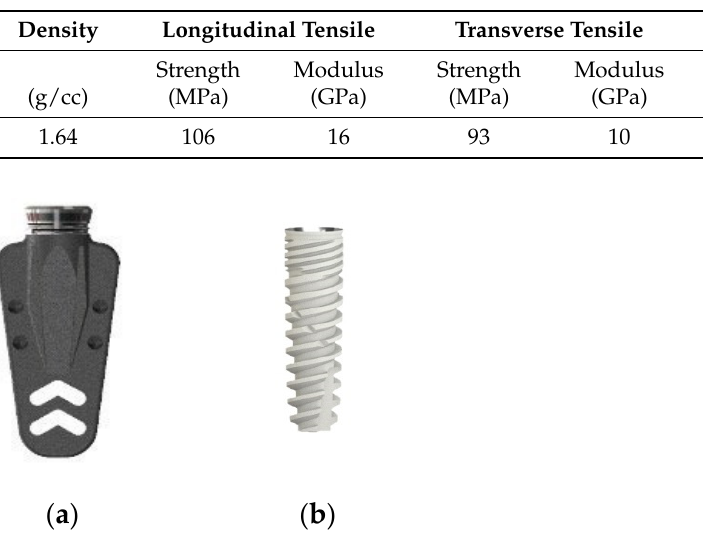
Figure 1. Implant system used in the experimental test ( a ) BlI and ( b ) STI.